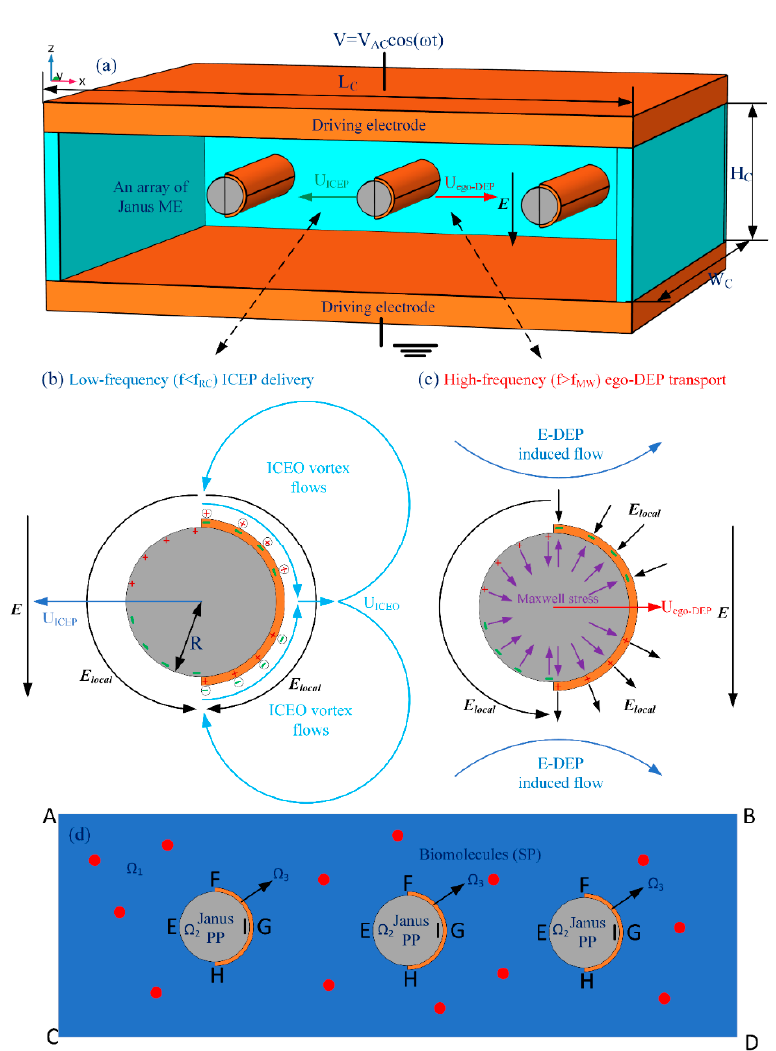
Figure 1. A schematic diagram of the direction-controllable electrokinetic transport of an array of cylindrical Janus mobile microelectrodes (ME) freely suspended in aqueous electrolyte under a uniform AC electric field, with the specific geometric size given in Table 1. ( a ) A 3D schematic diagram of the buoyancy-free Janus ME array that can move unidirectionally in perpendicular orientation to the externally-imposed AC forcing within a wide frequency range. ( b ) At frequencies below the inverse RC time scale for electrochemical polarization on the ideally polarizable surface of thin gold membrane, the induced-charge electrophoretic (ICEP) effect associated with induced-charge electroosmotic (ICEO) vortex flow field on the conducing end propels electrohydrodynamically the Janus ME to move in the direction of the insulating end. ( c ) At frequencies approaching and even exceeding the reciprocal charge relaxation time of the bulk electrolyte, ICEO vanishes due to electrochemical ion relaxation, and a net Maxwell stress from Maxwell-Wagner interfacial polarization renders the Janus ME array move electrokinetically in the direction of the conducting end, namely, the phenomenon of “ego-dielectrophoresis (e-DEP)”. ( d ) An illustrative simulation domain for the electrokinetic motion of buoyancy-free Janus microspheres (primary particle, PP) as mobile microelectrode arrays for microfluidic biomolecule (secondary particle, SP) collection within a wide frequency range. It is noteworthy that the background AC electric field is uniform and there is no field gradient far from the Janus ME array.